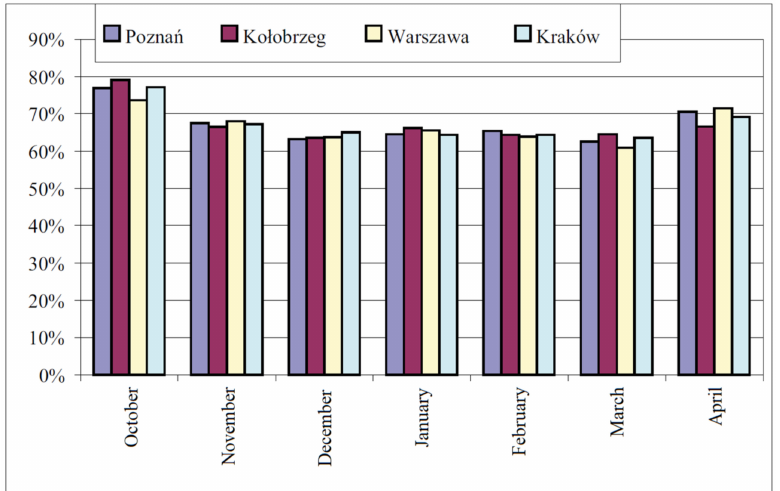
Figure 1. The percentage coverage of heat demand for ventilation through a ground heat exchanger (Pozna´n, Kołobrzeg, Warszawa, Krak ó w)